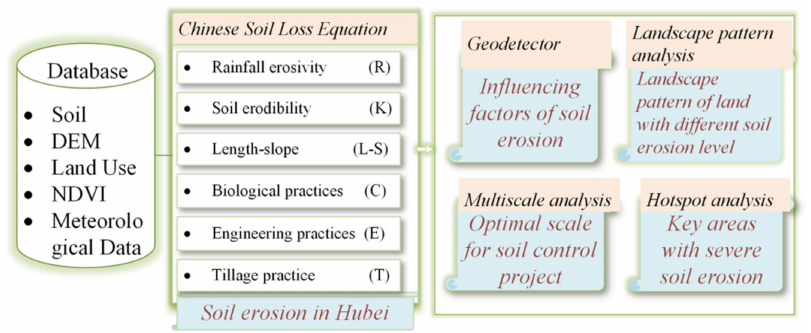
Figure 1. Workflow of this study.